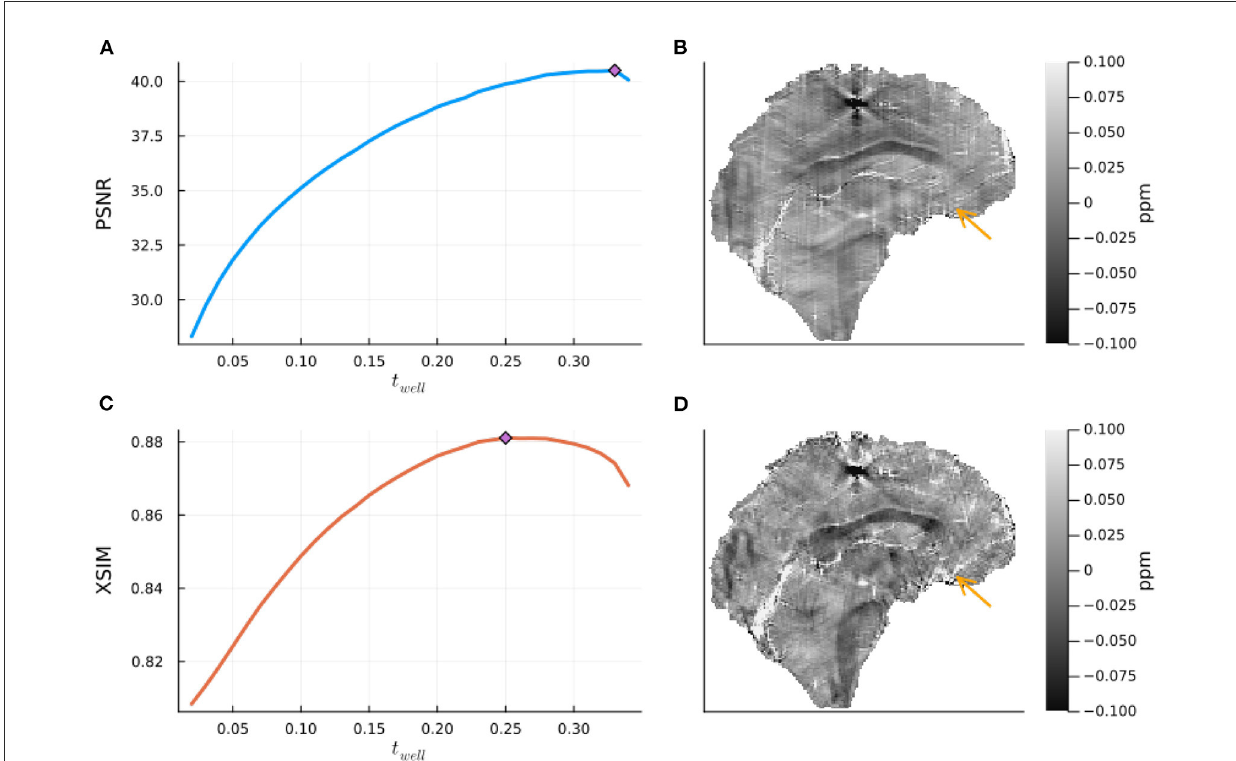
FIGURE3 The effect of the band-limit S k on the incomplete spectrum QSM reconstructed in the numerical phantom. On the left are the peak signal to noise Ratio (PSNR) and XSIM metrics for various threshold values t well , computed on the QSM challenge 2.0 dataset 2, with noise level 1 (A, C) . On the right are the corresponding optimal reconstructions (with the threshold for optimal PSNR (top) and XSIM (bottom) in a central sagittal slice (B, D) . The orange arrow points at a streaking artifact which is successfully suppressed at the higher regularization of the PSNR optimal value.